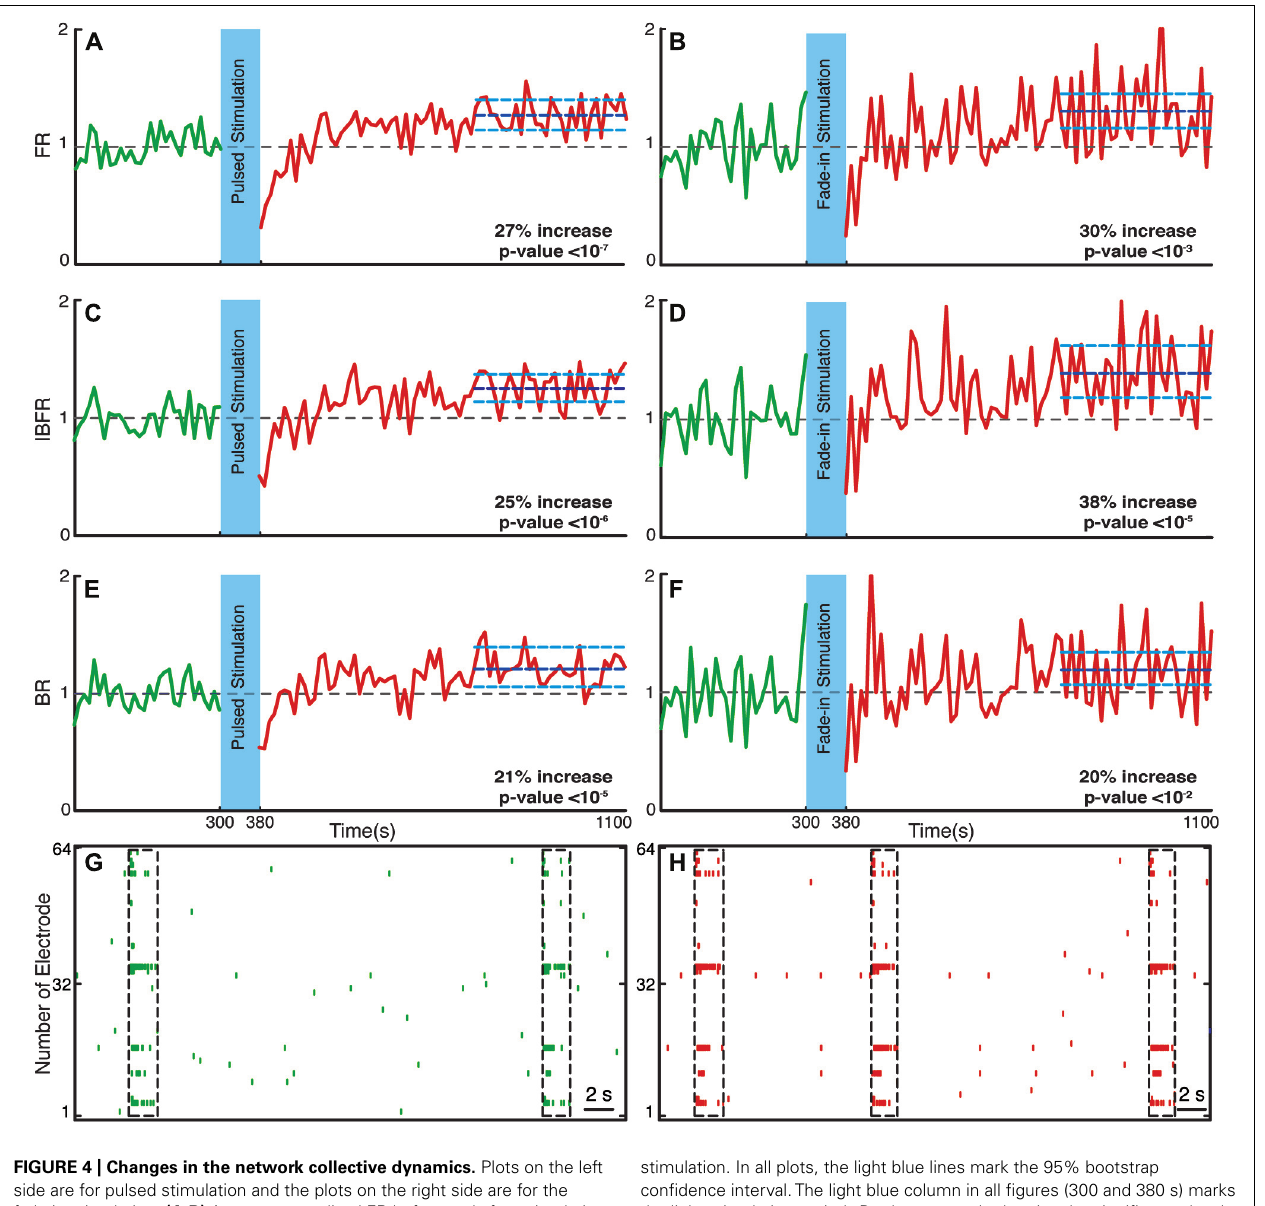
stimulation. In all plots, the light blue lines mark the 95% bootstrap confidence interval.The light blue column in all figures (300 and 380 s) marks the light stimulation period. P values on each plot give the significance level for the increase of FR, burst occurrence rate, or IBFR during the last 5 min of recording, respectively. Results for the pulsed stimulation are averages over 18 experiments in 18 cultures. Results with the fade-in stimulation are averages over 16 experiments in 16 cultures.